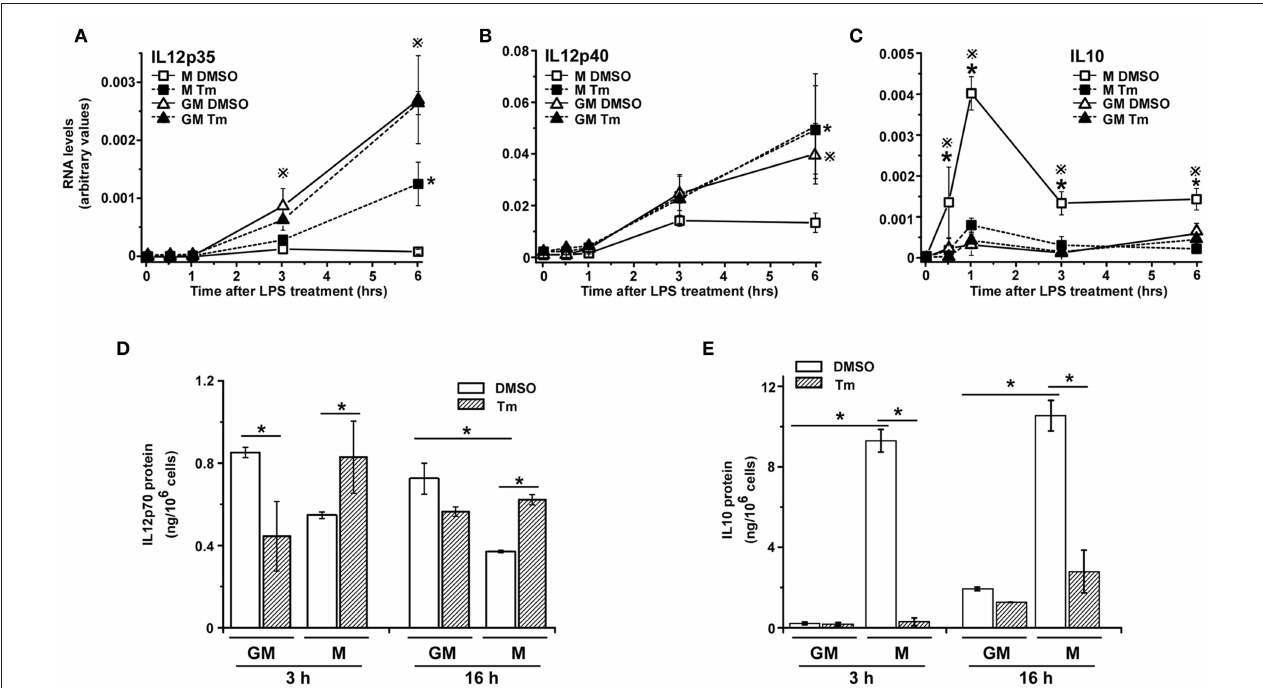
FIGURE 1 | Cellular stress modifies cytokine expression in BMDM. (A–C) M-BMDM and GM-BMDM were treated with DMSO or Tm (1 µ g/ml) for 6h prior to stimulation with LPS (100ng/ml) for the indicated times. Levels of IL12p35 (A) , IL12p40 (B) , or IL10 (C) mRNA levels were determined by real time PCR and are presented as described in Materials and Methods. (D,E) M-BMDM and GM-BMDM were treated with DMSO or Tm for 6h followed by LPS for 3h. The cells were washed 3 times with warmed PBS, fresh medium was added and incubation continued for another 3 or 16h. Supernatants were collected and used to determine protein levels of IL12p70 (D) and IL10 (E) by ELISA. Data are presented as the mean ± SD for triplicate experiments and the differences between the indicated treatments were evaluated by two way-ANOVA and Turkey’s multiple comparisons test. In (A–C) , P < 0.05 is indicated by * for comparison of stress vs. DMSO in M-BMDMs, by # for comparison of stress vs. DMSO in GM-BMDMs, by ※ for comparison of M DMSO vs. GM DMSO and by 9 for comparison of M-BMDM stress vs. GM-BMDM DMSO. In (D,E) , P < 0.05 is indicated by * for comparison of the indicated